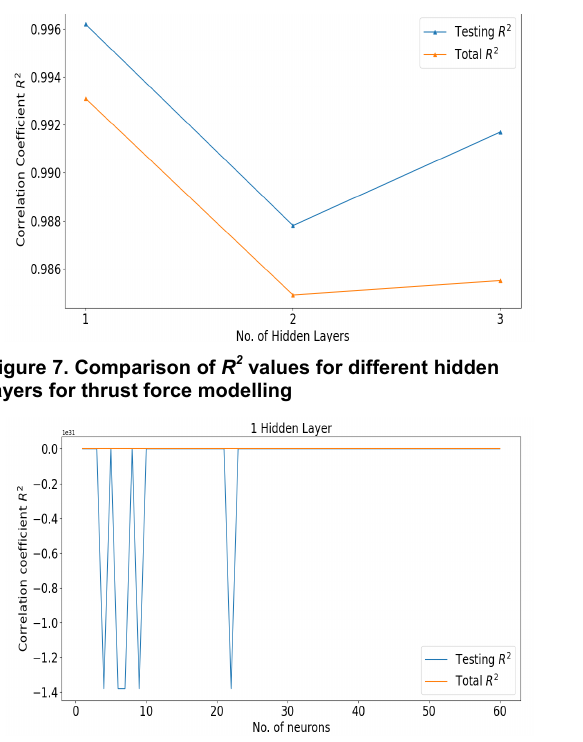
Figure 6. R 2 values obtained from brute-force method for thrust force modelling